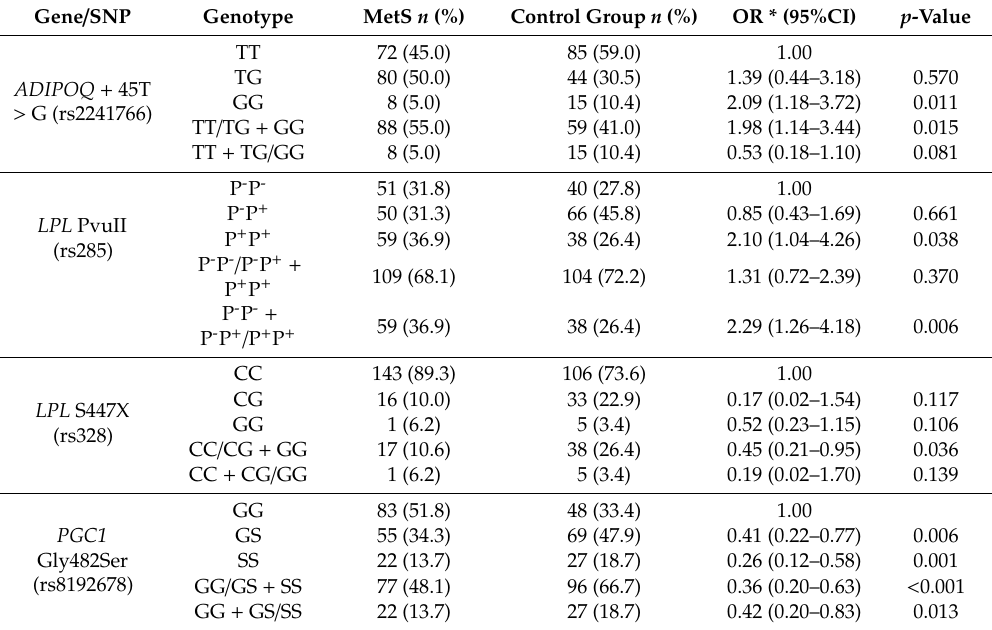
Table 4. Genotype frequencies of polymorphisms associated with MetS.